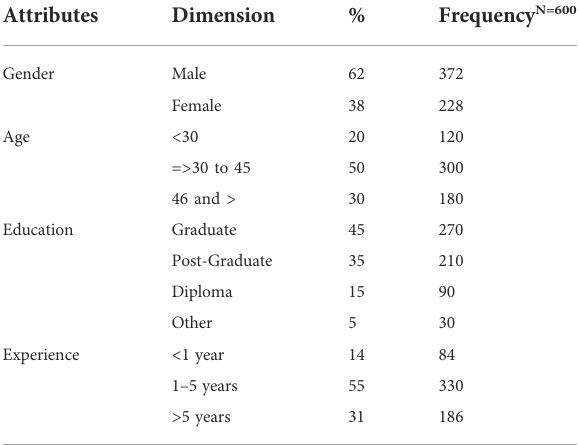
Table 4 for the current study. It is evident that the multifaceted impact of social capital indicators on company value is statistically